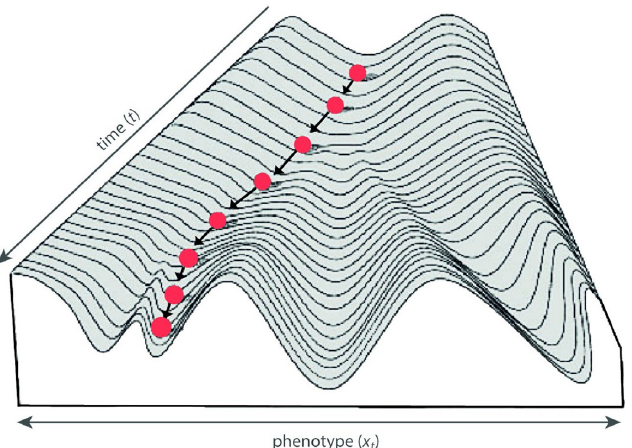
Fig 1. Epigenetic landscape. Conrad Waddington’s epigenetic landscape is a landscape over a phenotype space and a time dimension, illustrating the canalization of individual development (the marble) around a target trajectory (the valley floor). Branching valleys represent cell fates, or more generally, predetermined ontogenetic pathways (“chreod”), where the branching points relate to alternative differentiations. The steepness of the walls represent the strength of canalization, the tendency of individual development to return to the chreod (modified from [27], after [2]).